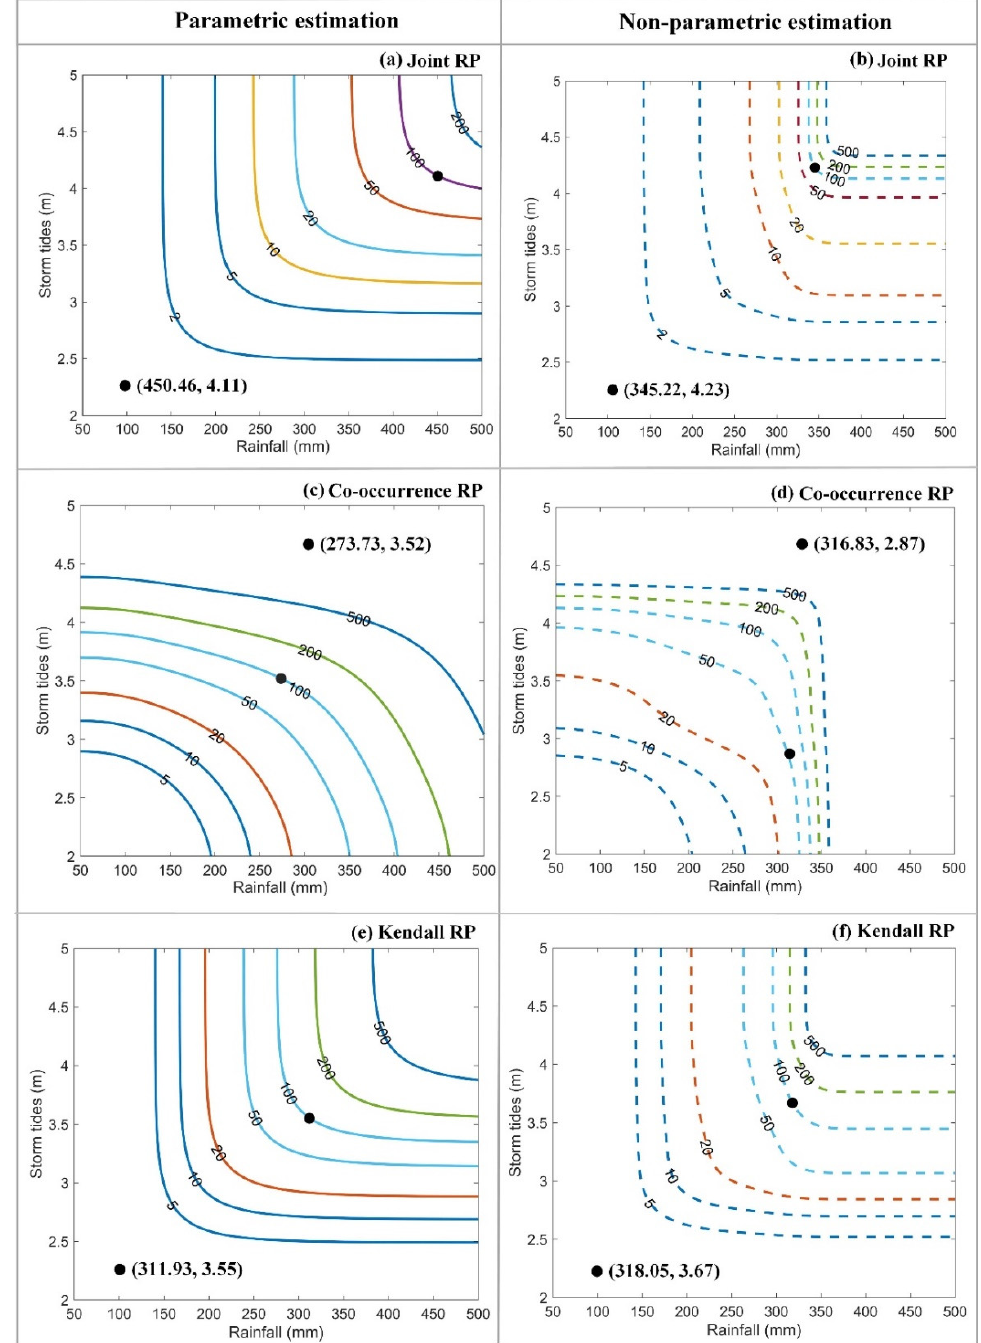
Figure 10. RP contour plots of rainfall and storm tides. ( a , c , e ) are the contour plots of joint RP, co-occurrence RP and Kendall RP obtained by the parametric estimation approach, respectively. ( b , d , f ) are the contour plots of joint RP, co-occurrence RP and Kendall RP obtained by the non-parametric estimation approach. Black points represent the bivariate design values of RP = 100 a.